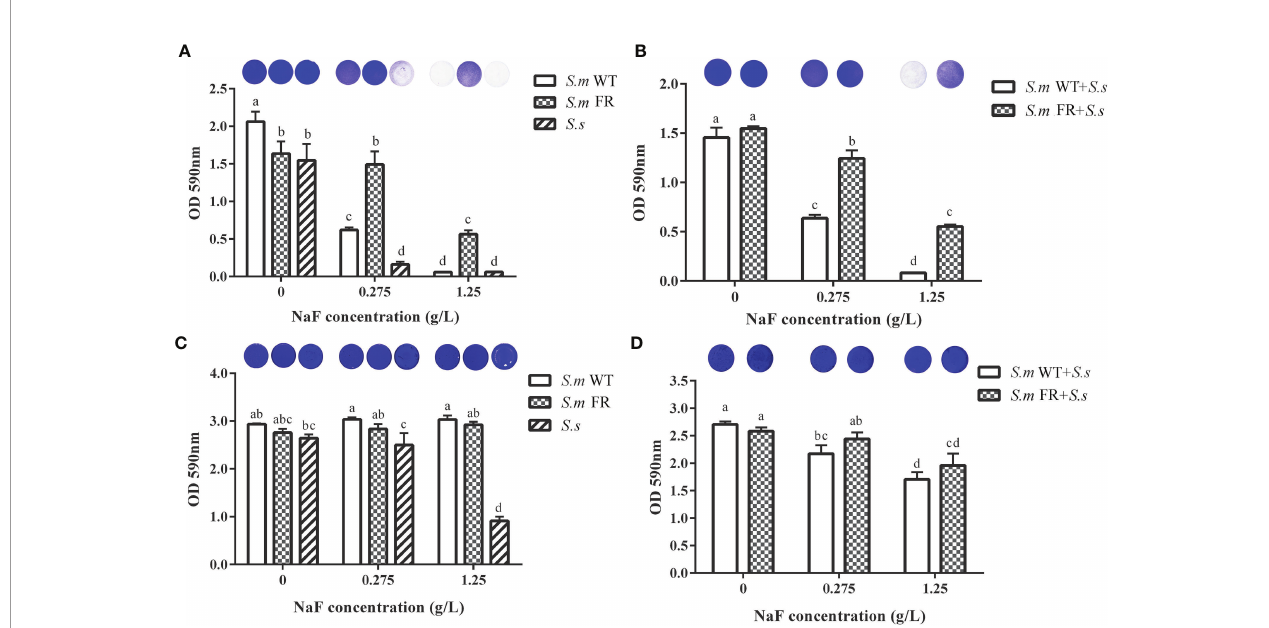
FIGURE 2 | Biomass measured using crystal violet staining. (A) Single-species bio fi lm formation. (B) Dual-species bio fi lm formation. (C) Pre-formed single-species bio fi lms. (D) Pre-formed dual-species bio fi lms. The same letters indicate no statistical difference, and different letters indicate a signi fi cant difference between groups ( P < 0.05).